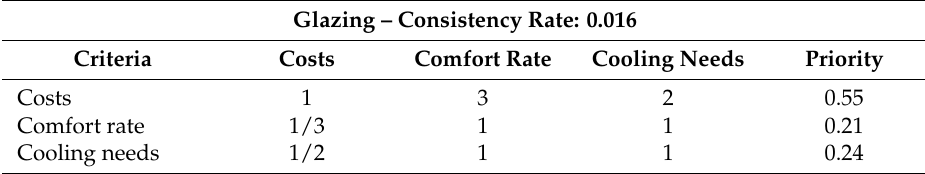
Table 8. Pairwise comparison matrix of criteria for